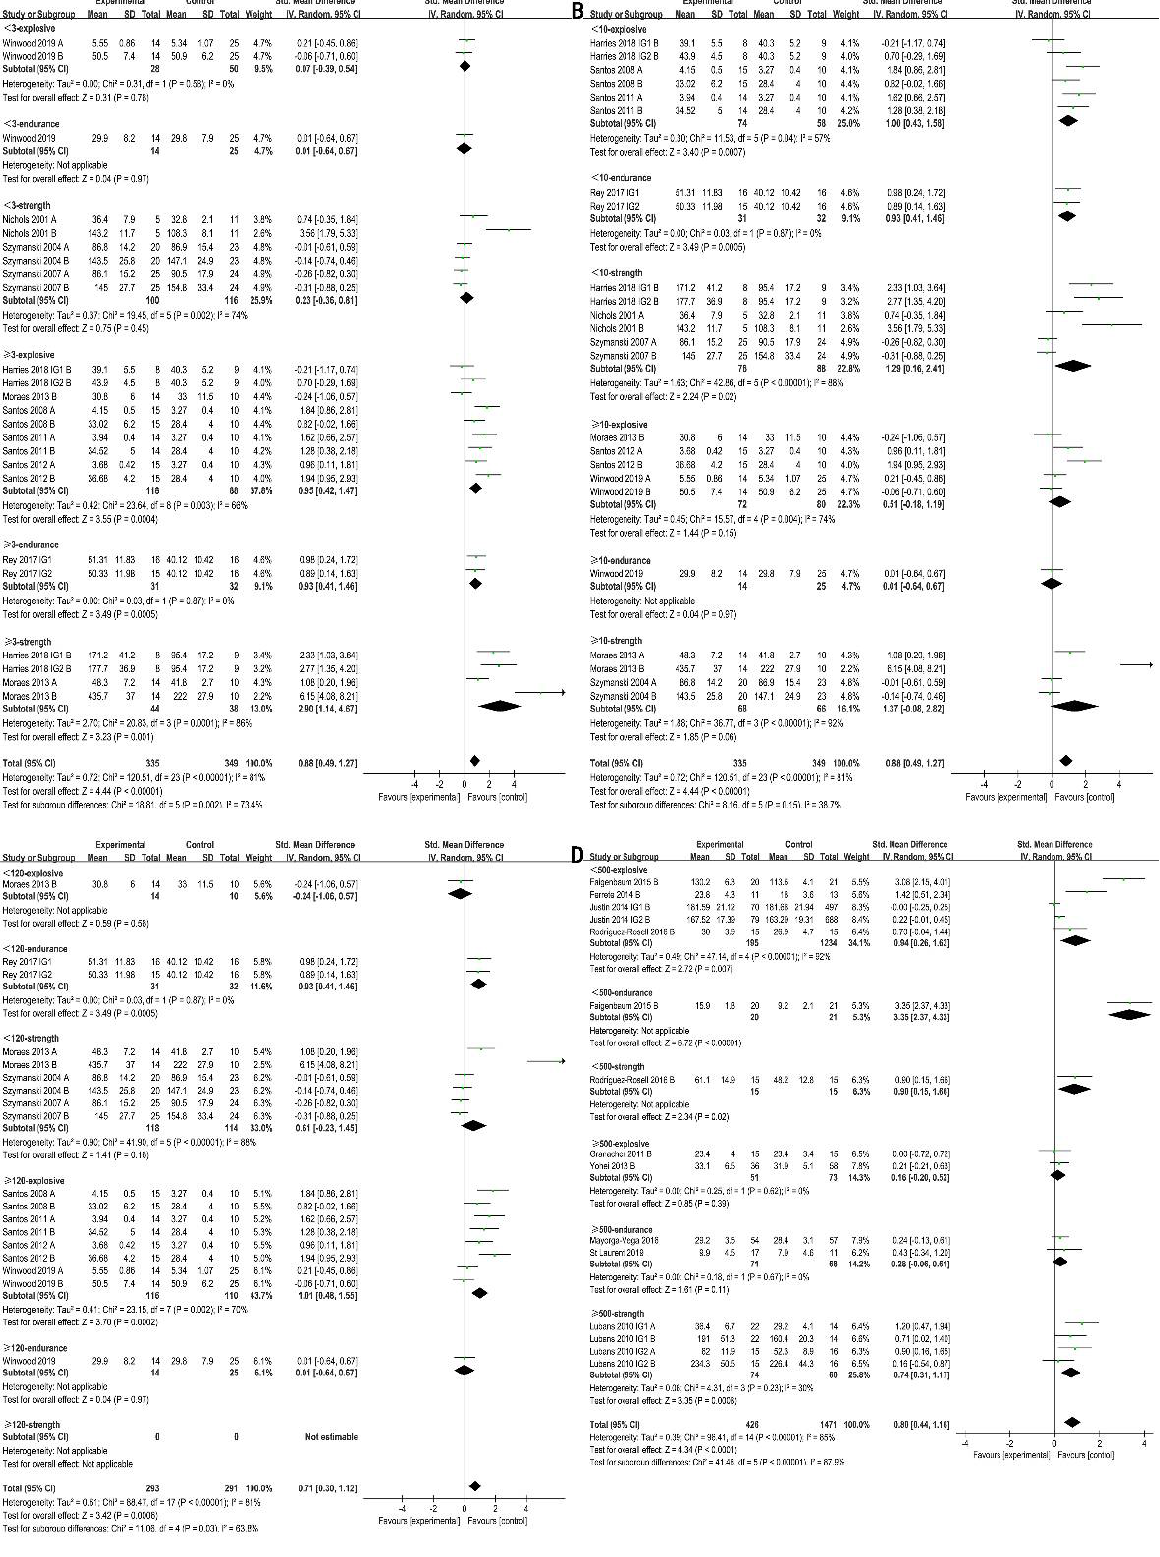
Figure 5. Effects of training volume on muscle fitness. ( A ): Effects of sets per session on muscle fitness; ( B ): Effects of repetitions per set on muscle fitness; ( C ): Effects of rests between sets on muscle fitness; ( D ): Effects of energy expenditure on muscle fitness; A: upper limb; B: lower limb. 4. Discussion This meta-analysis examined the impact of physical activity on the muscle fitness of children and adolescents and explored the effects of specific physical activity elements. In this study, we found that physical activity has a positive impact on the muscle fitness of children and adolescents, with a moderate impact on muscle explosive power, and a strong effect on muscle endurance and muscle strength. Moreover, we found that the